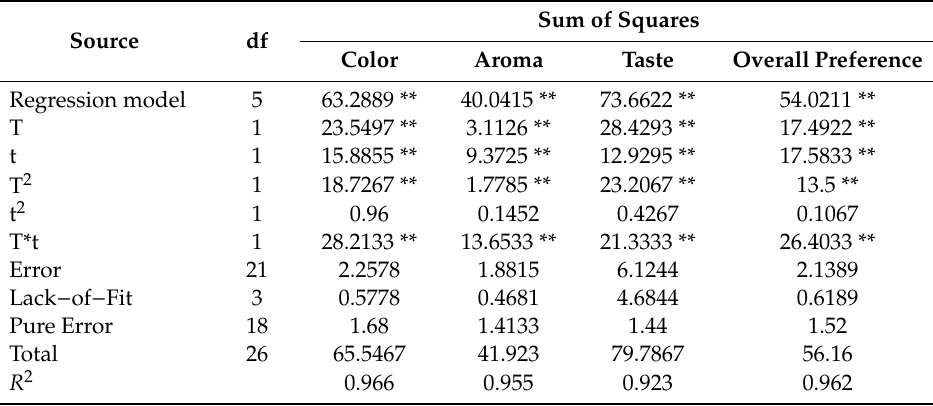
Table 7. Analysis of variance for of the sensory attributes of full-fat